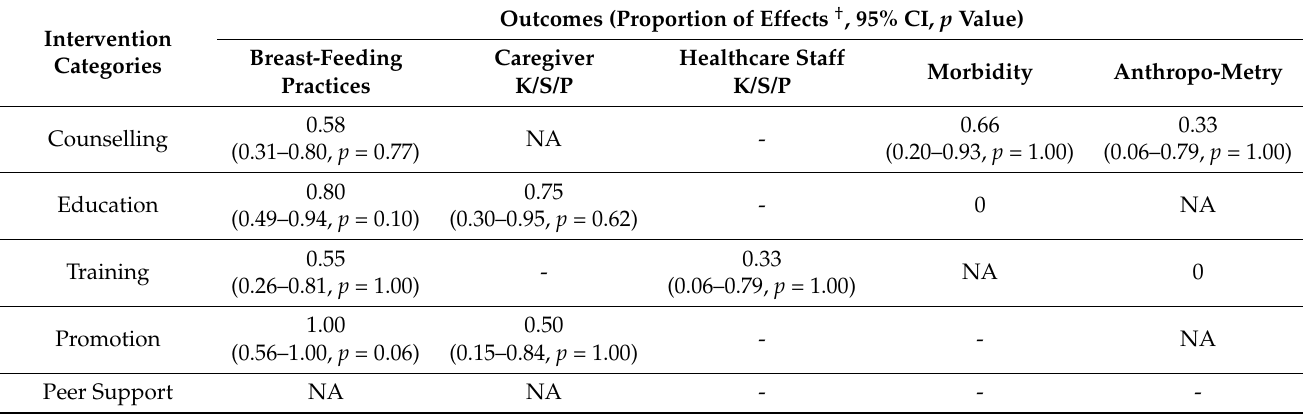
Table 3. Synthesis using vote counting based on direction of effects for five intervention categories.